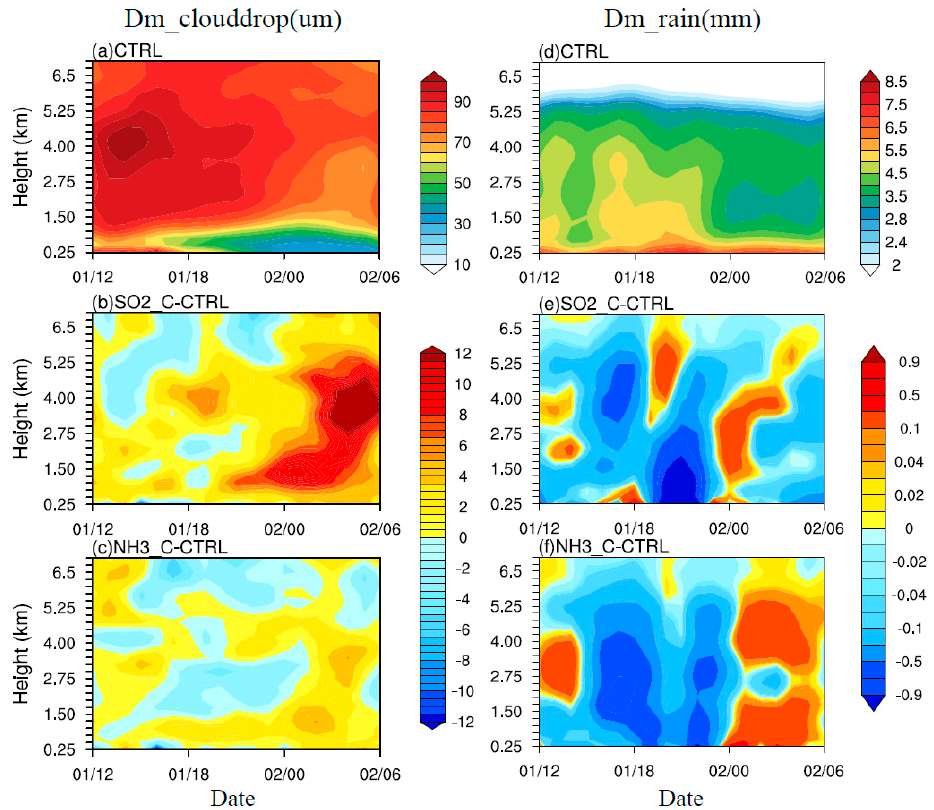
Figure 11. Time-height evolutions of area-averaged mass-weighted mean diameter of ( a ) cloud droplets (um) and ( d ) raindrops (mm) within the vortex in CTRL run, ( b , e ) the differences between SO2_C and CTRL runs, and ( c , f ) the differences between NH3_C and CTRL runs.